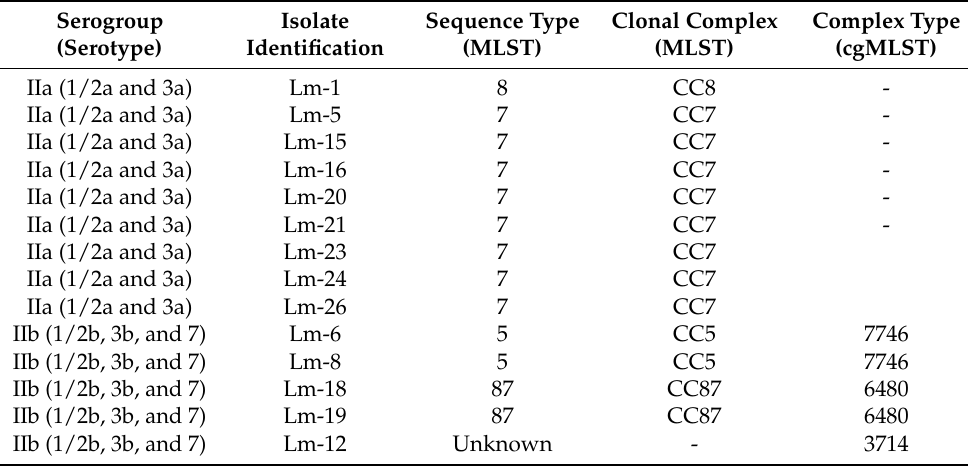
Table 3. Characterisation of L. monocytogenes isolates at different zones of the frozen vegetables plant.